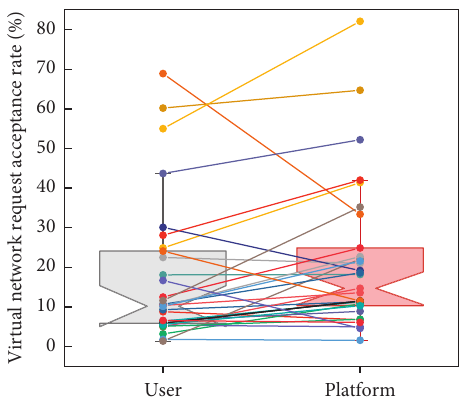
Figure 6: Virtual network request acceptance rate.